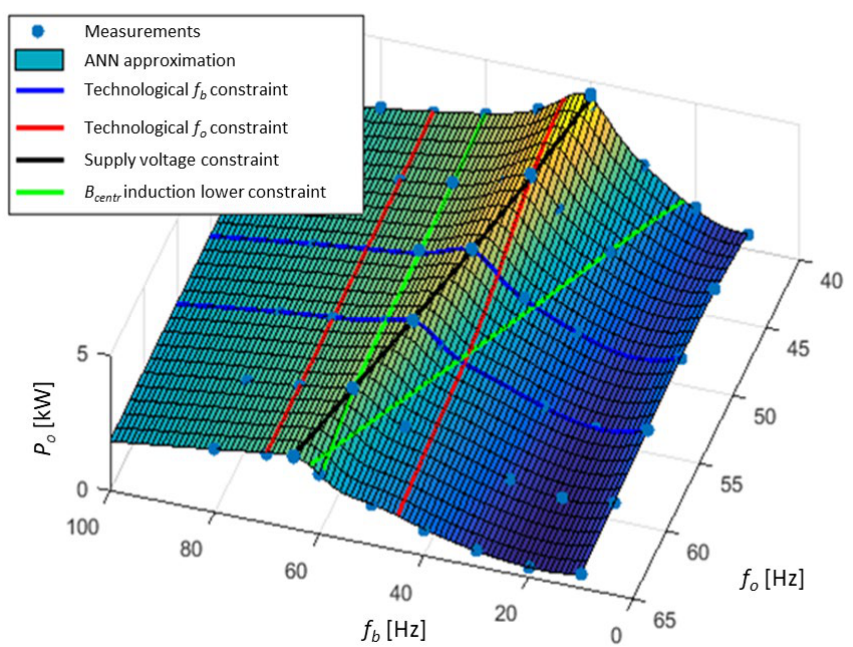
Figure 10. Constraints on the static characteristics of the active power of the